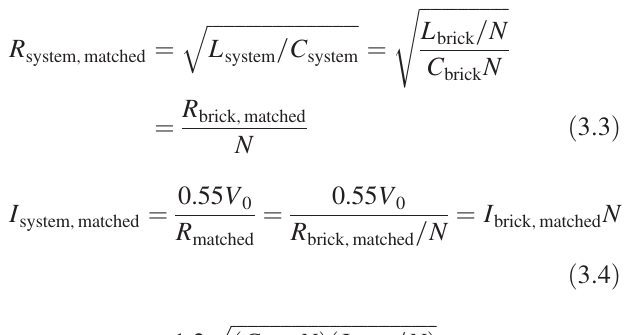
TABLE II. Scaling of system output parameters with N when L